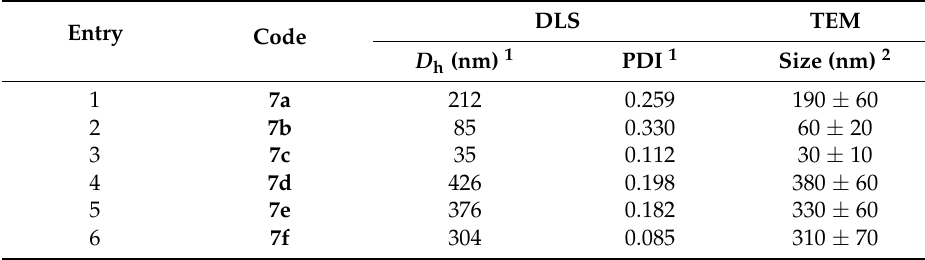
Table 3. Results of DLS and TEM measurements of 7